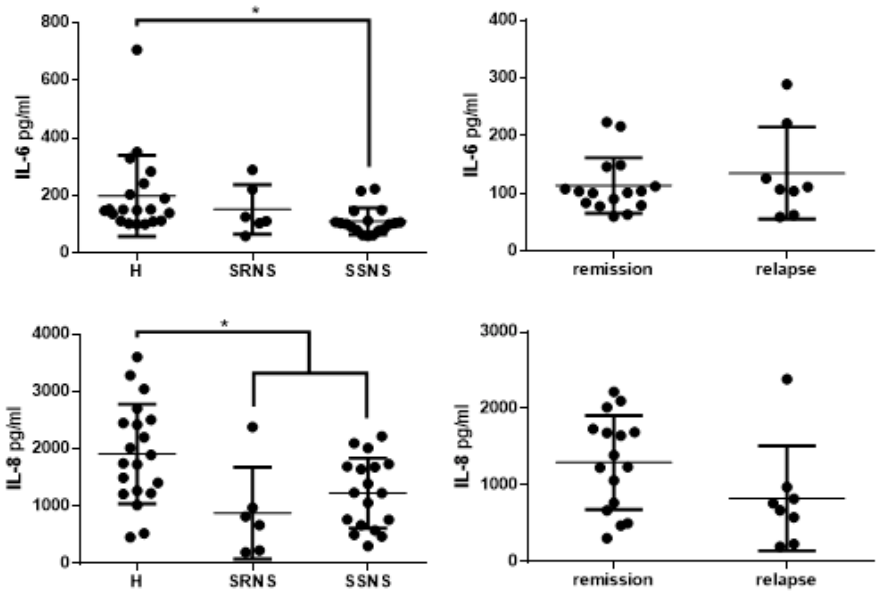
Figure 2. Levels of IL-6 and IL-8 from the saliva of children with nephrotic syndrome and healthy controls. Samples from children with nephrotic syndrome were classified according to steroid-resistant nephrotic syndrome (SRNS) and steroid-sensitive nephrotic syndrome (SSNS); and according to the remission and relapse states. Levels of IL-6 and IL-8 were quantified by ELISA. The values are presented as means and SD. * represents a statistically significant di ff erence between the groups ( p = 0.045 for IL6; p = 0.005 for